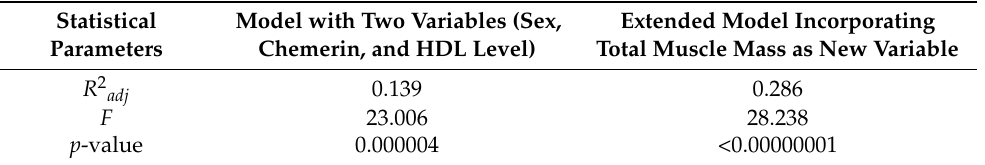
Table 3. Comparison of the stepwise multiple regression model explaining variations in NPQ levels before and after adding the fourth variable (total muscle mass) to the basic model, which includes sex, chemerin, and HDL levels in the entire examined population ( n =